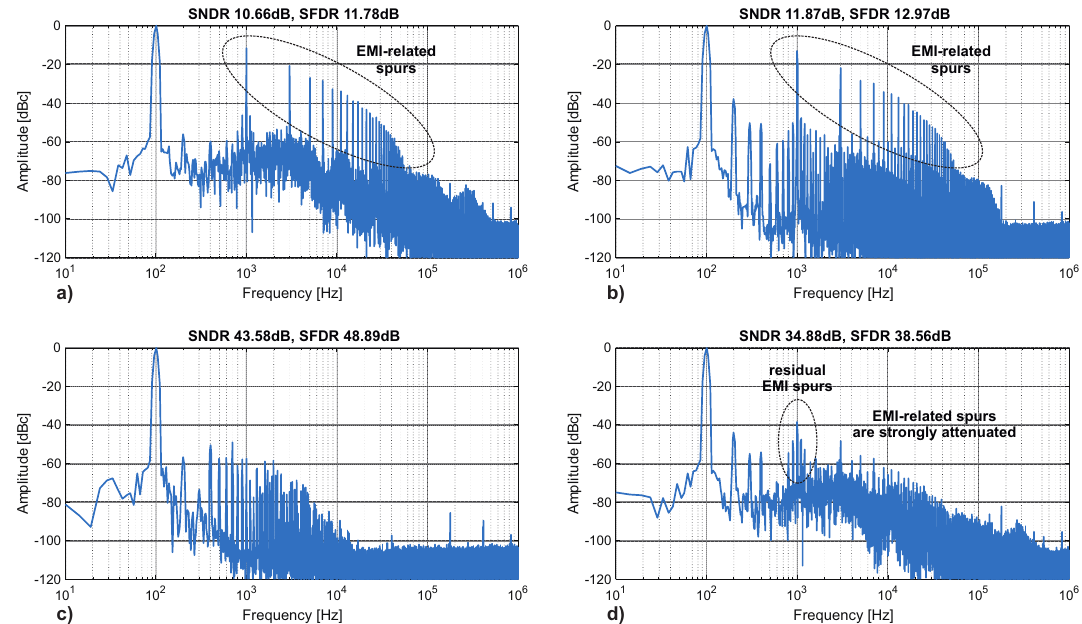
Figure 12. Spectra of the measured signals under 9dBm AM EMI excitation reported in Figure 9: ( a ) OPA2277 opamp output voltage with EMI injection; ( b ) MCP6V02 opamp output voltage with EMI injection; ( c ) nominal input signal spectrum as in Figure 8b; ( d ) Output voltage with EMI injection estimated starting from the EMI corrupted waveforms in ( a , b ), by the proposed EMI-induced errors suppression procedure with α =